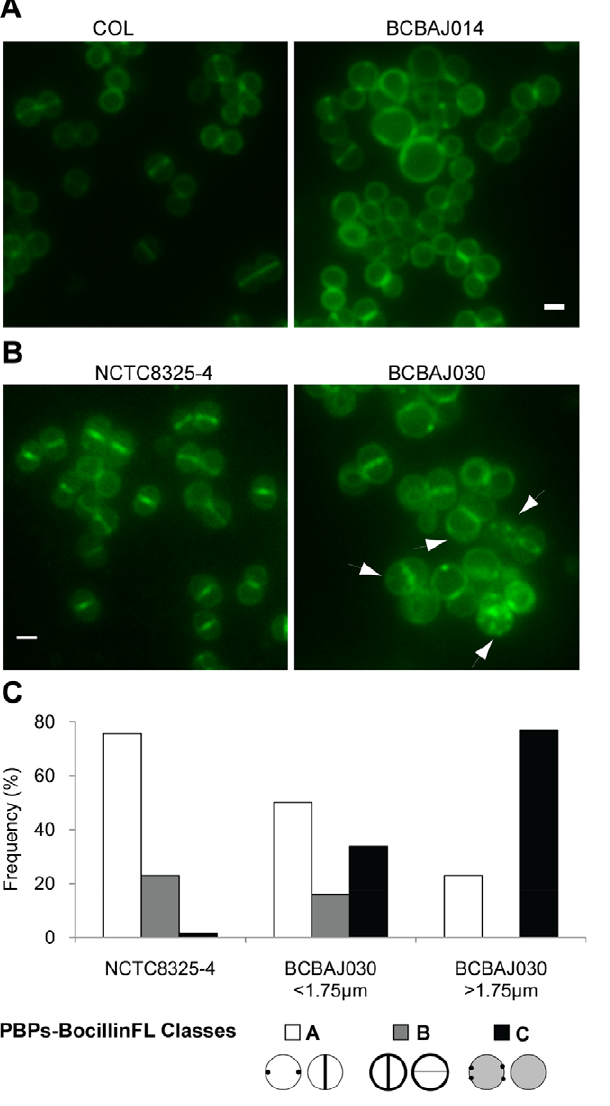
Figure 6. Penicillin Binding Proteins (PBPs) mislocalize in large S. aureus cells depleted of EzrA. (A) COL (parental strain) and BCBAJ014 (COL D ezrA ) cells labeled with Vancomycin-FL to visualize sites of incorporation of new cell wall. (B) NCTC8325-4 (parental strain) and BCBAJ030 (NCTC8325-4 D ezrA ) cells labeled with Bocillin-FL. Arrows point to cells with irregular localization of PBPs. Scale bar 1 m m. (C) Frequency of cells showing septal localization of PBPs (class A), localization around the membrane (class B) or irregular localization of PBPs (class C) for NCTC8325-4 and BCBAJ030 cells. The later were divided in two classes - cells with a diameter smaller or larger than 1.75 m m – which were analyzed separately.